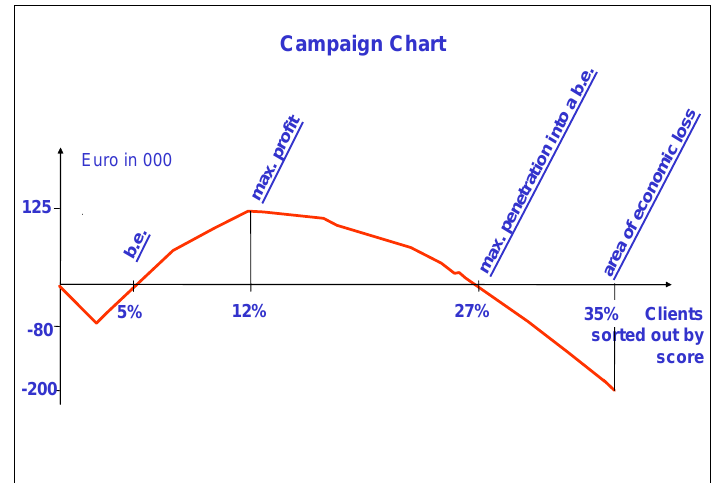
Figure 1: Campaign